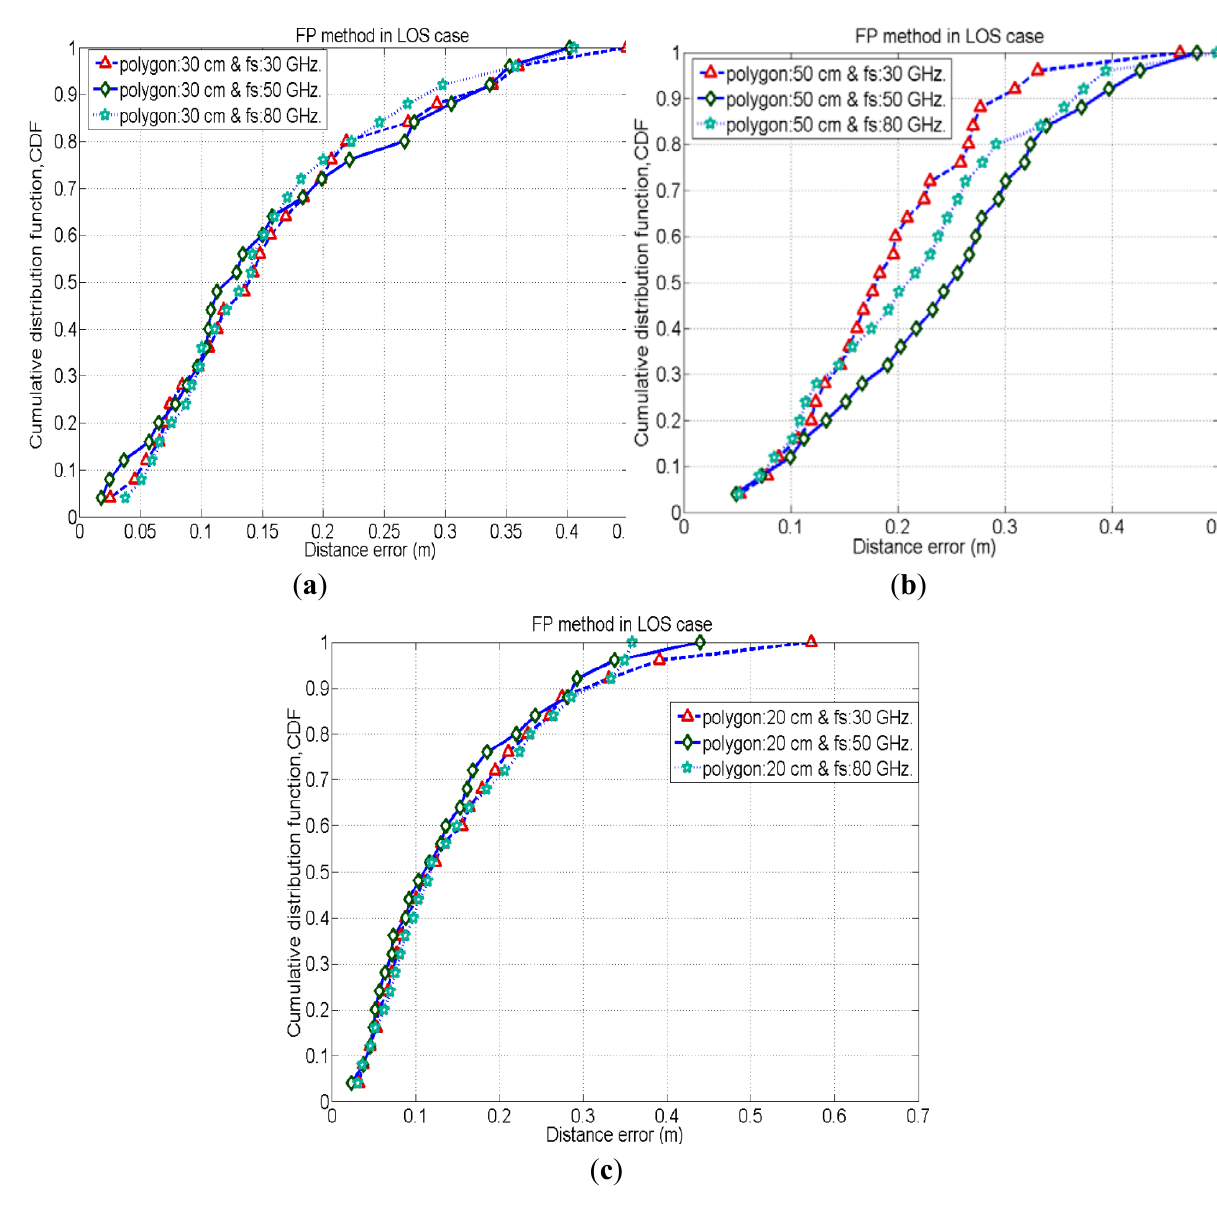
Figure 6. CDF of the distance errors for FP method in different cases with